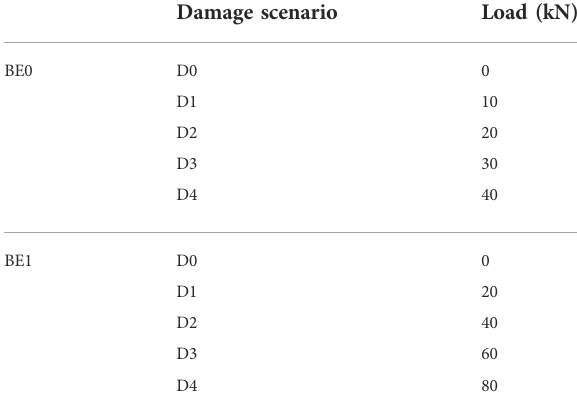
TABLE 3 Damage scenarios of steel-ECC composite deck of experimental test.